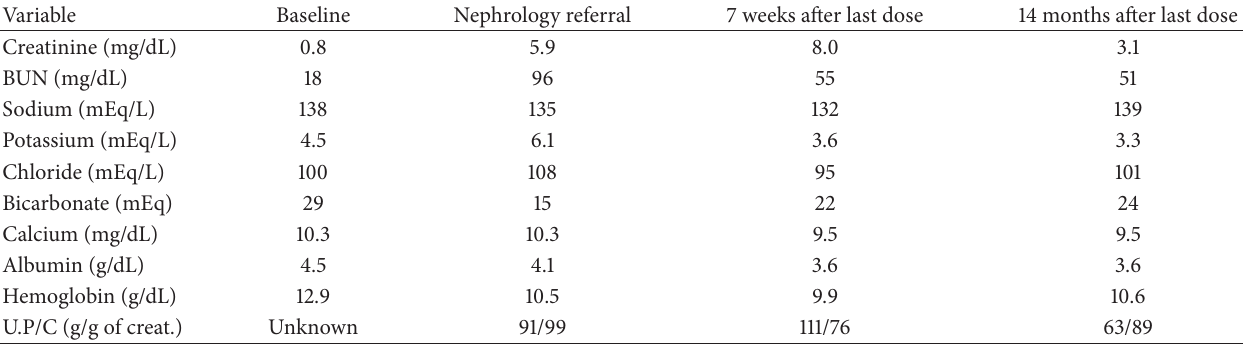
Figure 1: Light microscopy renal biopsy results (H&E stain). Renal biopsy showing changes of ATN. (a) Proximal tubules are mildly dilated and simplified in appearance. Scattered tubules contain denuded and necrotic epithelial cells (arrows). Patchy very mild interstitial inflammation is seen in the right upper-hand corner. Glomeruli (G) exhibit only mild mesangial prominence; art: distal artery (H&E stain, original magnification = 100x). (b) Higher magnification reveals attenuation of proximal tubular epithelium with loss or disruption of brush border. The interstitium exhibits edema superimposed upon mild fibrosis (H&E stain, original magnification = 400x). Table 1: Laboratory data